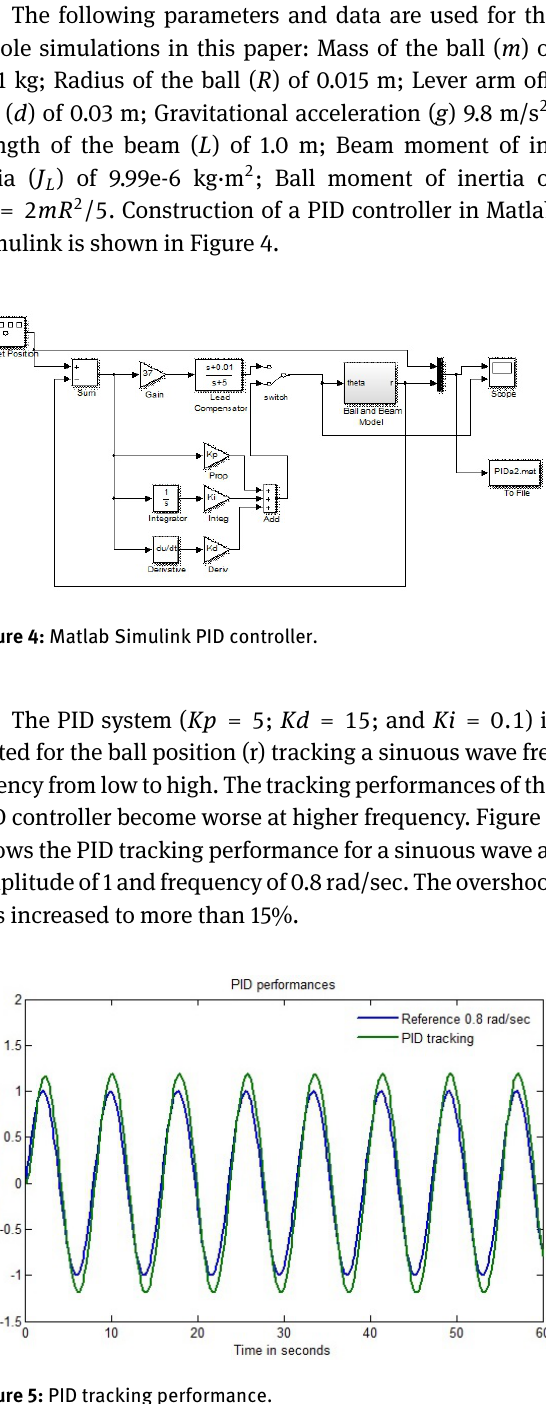
The PID is destabilized after 40 secs for tracking a sin- uous wave frequency of 0.81 rad/sec as shown in Figure 6. acceleration and velocity to its